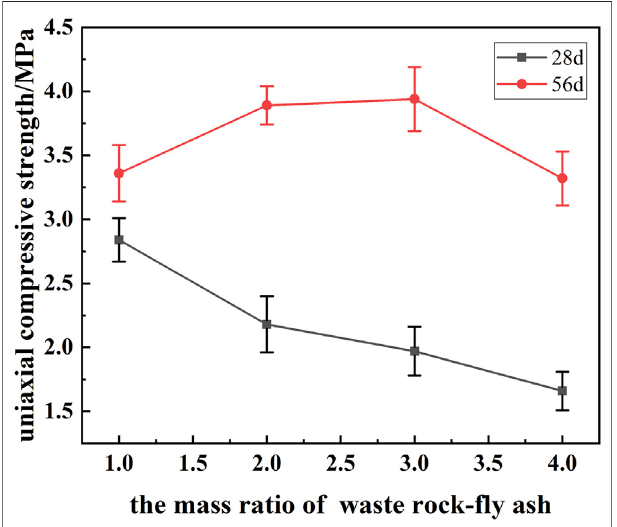
FIGURE 10 | The relationship between back fi ll strength and waste rock to tailings ratio (group D).